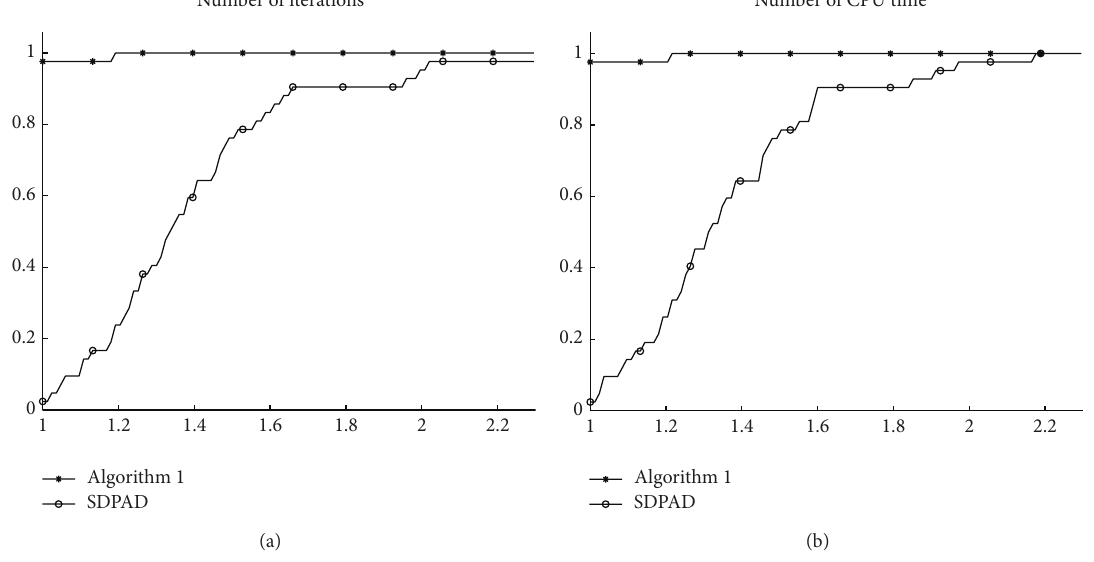
Figure 1: Performance profiles for SDPAD and the present method for number of iterations (a) and CPU time (b). Table 1: Numerical results compared with [16] for computing frequency assignment